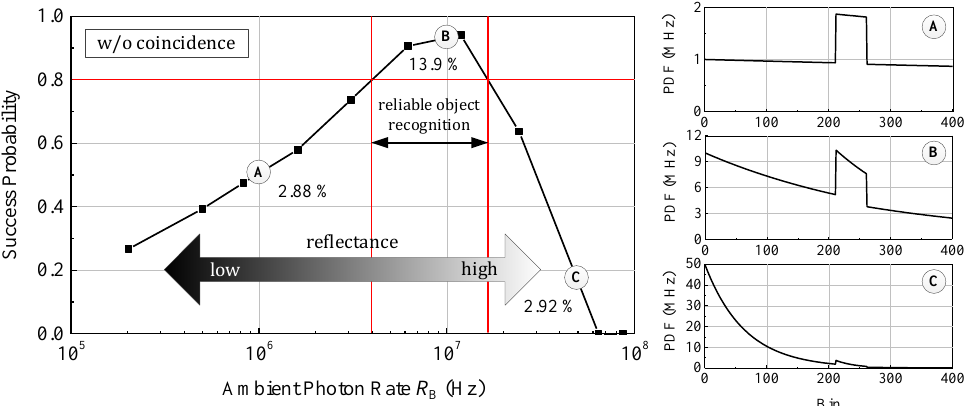
Figure 10. Success probability of the distance measurement at 100 klx ambient sunlight without photon coincidence vs. the background photon rate at constant SBR corresponding to varying target reflectance. Only for a small range in reflectivity a good measurement performance is achieved.